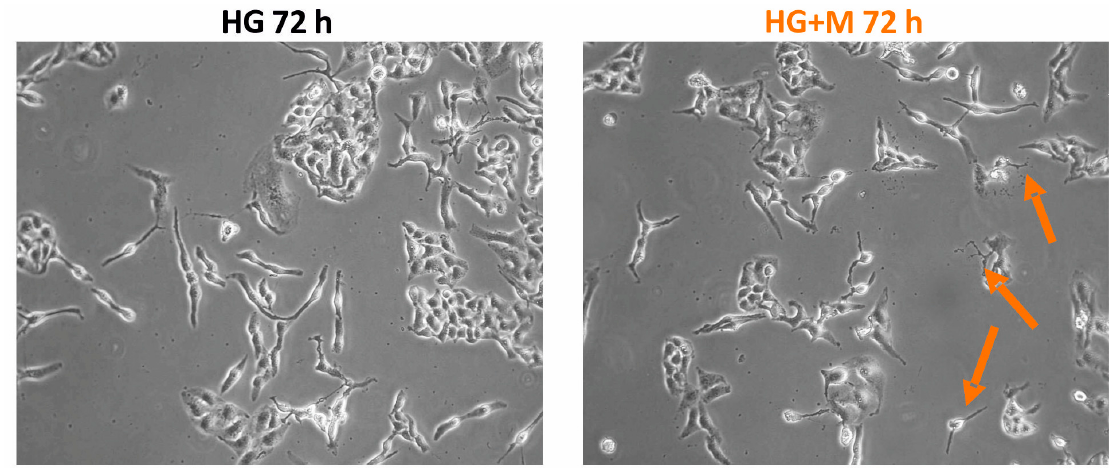
Figure 3. The morphology of SKOV-3 cells treated for 24–72 h with metformin (10 mM) in high glucose medium examined under an inverted microscope (Olympus IX70, Japan), (scale bar = 100 µ m), elongated, thin cells (orange arrows).